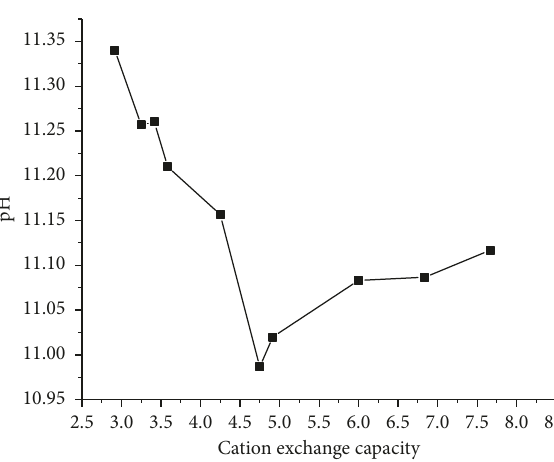
Figure 3: Curve of cation exchange capacity of the slurry fluid.